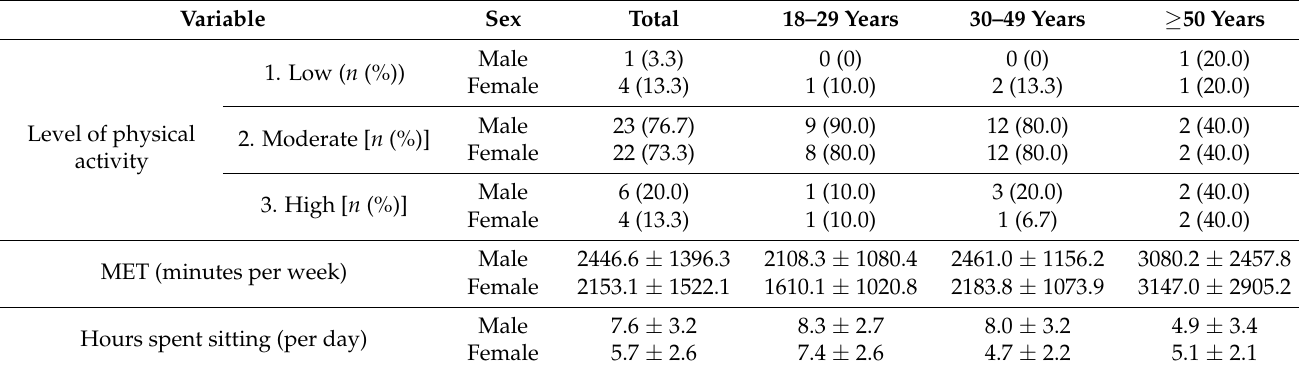
Table 7. International Physical Activity Questionnaire, short form: